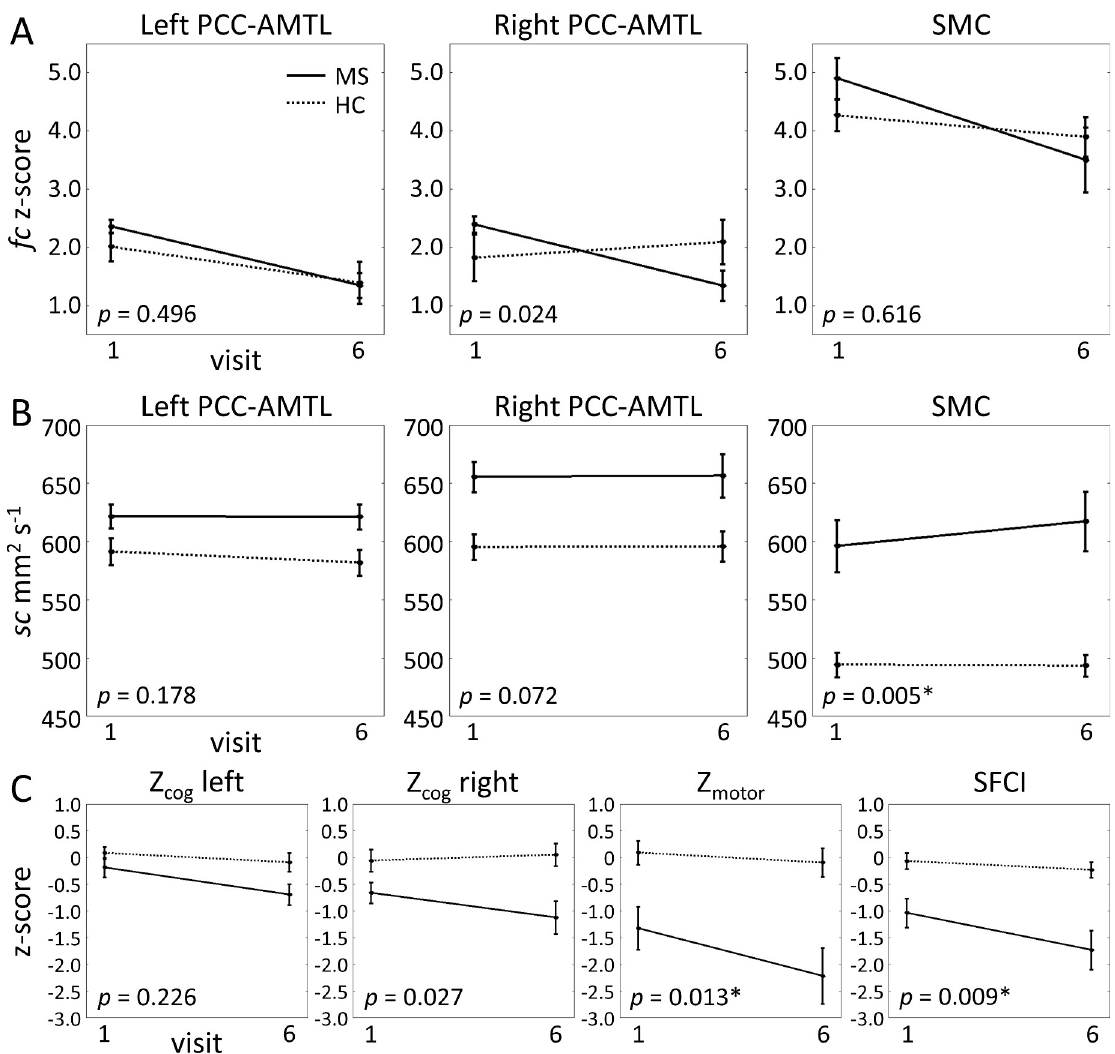
Fig 5. Group-averaged imaging measures. Group-averaged imaging measures plotted for MS and controls at baseline (1) and final visit (6). Error bars represent standard error. LRT p -values are included in each plot. A. rsfMRI ( fc ), B. DTI ( sc ), and C. SFCI component measures in the tracks of interest. � denotes significant result. HC = healthy controls; see Table 3 for additional abbreviations.